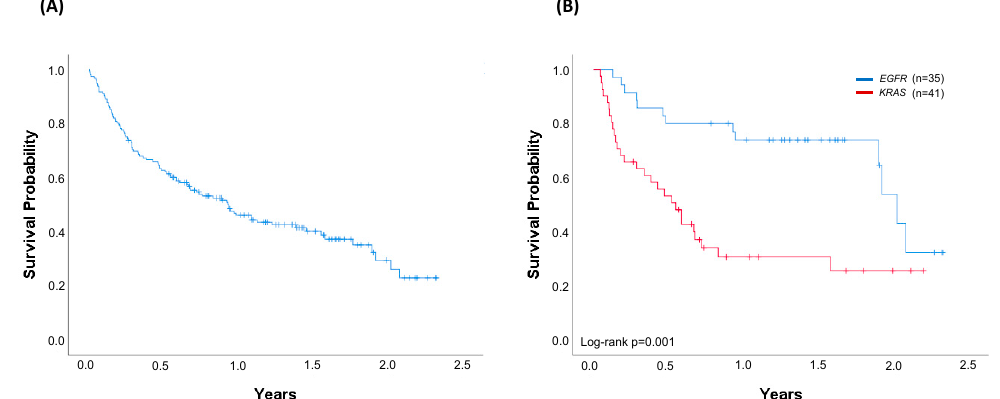
MET Δ ex14, the third most common oncogenic driver alteration, the median OS was 1.77 years (95% CI 0.94–2.60).